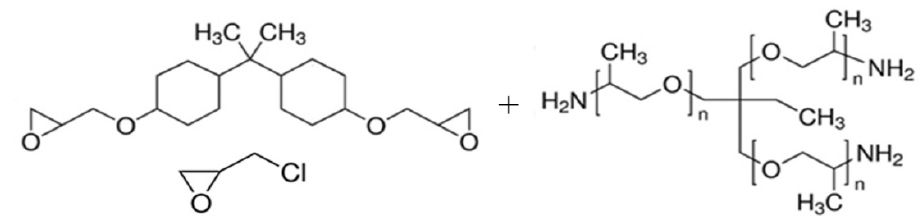
Figure 1. Structural formula of the component A—hydrogenated bisphenol A polymer with epichlorohydrin (left) and the component B—trimethylolpropane tris[poly(propylene glycol), amine terminated] ether.